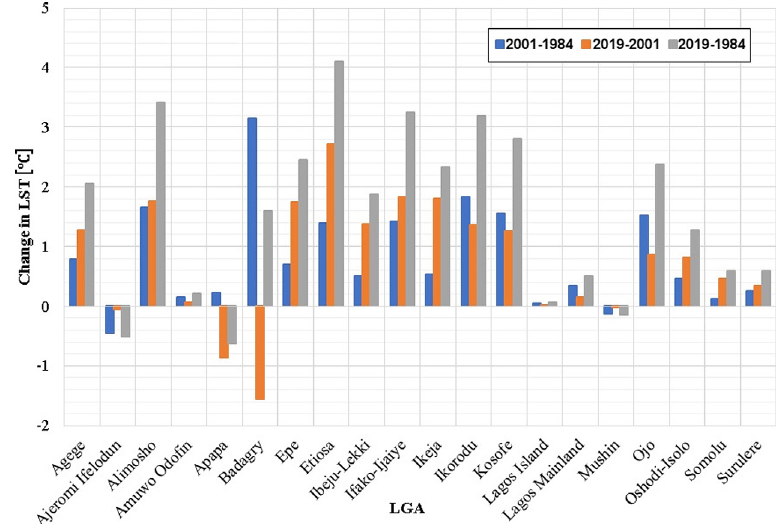
fig. 7. Changes in mean LST.